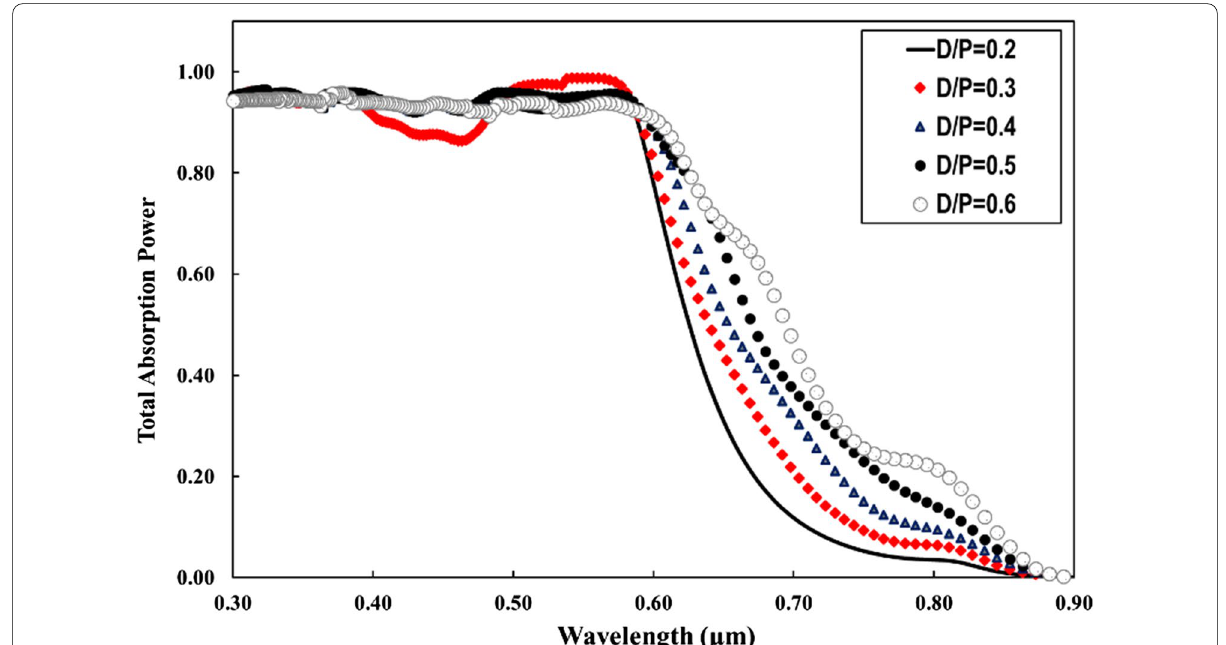
Fig. 2 The total absorption performance of GaAs NW with different D / P ratios without incorporation of Au metal